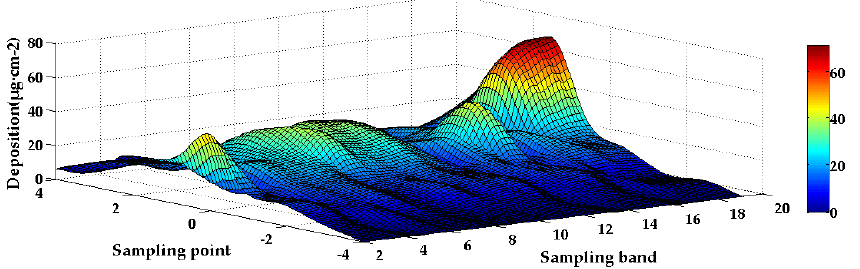
Figure 22. Droplet depositions in operation units.